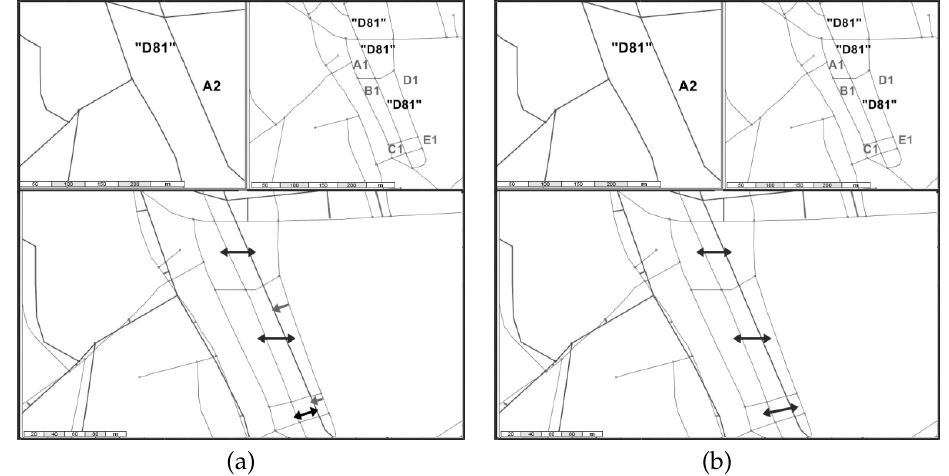
Figure 7: Matching results with (a) and without (b) using the Name Criterion . In both sub- figures the less detailed dataset (BDCARTO) is represented in the upper left corner, and the most detailed dataset (MultiNet) in the upper right corner. Both dataset are overlapped in the bottom. Single arrows represent wrong-matched links and double arrows represent correct links.